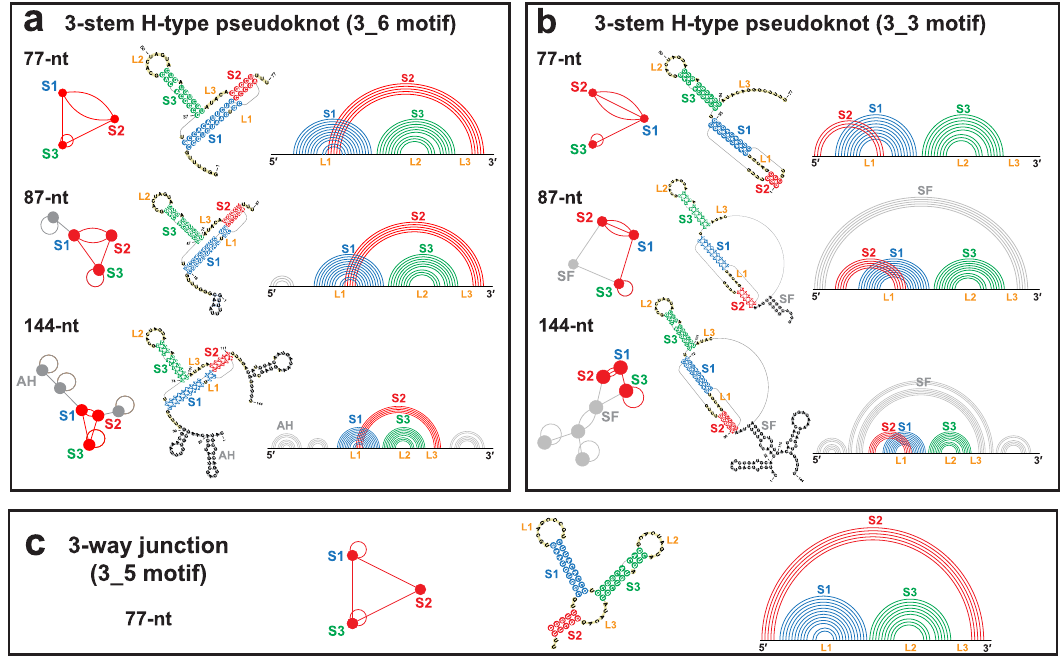
Fig. 1 Secondary structures of the three FSE motifs. a 3_6 pseudoknot, ( b ) 3_3 pseudoknot, and ( c ) 3_5 junction at different lengths we study, along with their arc plots and corresponding dual graphs. For 77-nt, the 3_6 pseudoknot, 3_3 pseudoknot, and 3_5 junction have common Stems 1 (blue) and 3 (green), while different Stem 2 (red). The two pseudoknots are classi fi ed as H-type 78 , where in 3_6 the loop region of Stem 1 binds with the external single-stranded 3 0 end, and in 3_3 the Stem 1 loop binds with the 5 0 end. For 87-nt, 10 upstream residues are added that include the 7-nt slippery site, and the 3_3 conformation contains an extra fl anking stem SF (gray). For 144-nt, 37 upstream and 30 downstream residues are included, and extra stems (gray) are formed, including attenuator hairpin AH for 3_6 and SF for 3_3. Stems are represented as vertices in dual graphs, and loops as edges, with the central 3_6, 3_3, and 3_5 submotifs corresponding to the 77-nt FSE region highlighted in red, and the fl anking vertices/edges corresponding to the extra stems/loops in